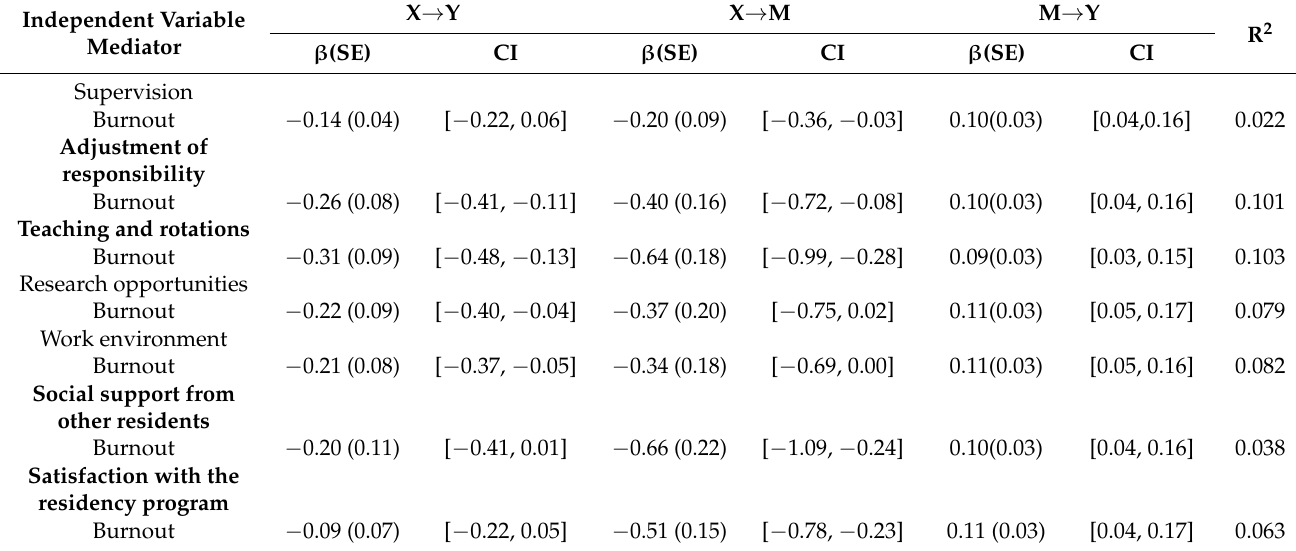
Table 6. Results of mediational analyses of the effect of working factors on perceived errors via